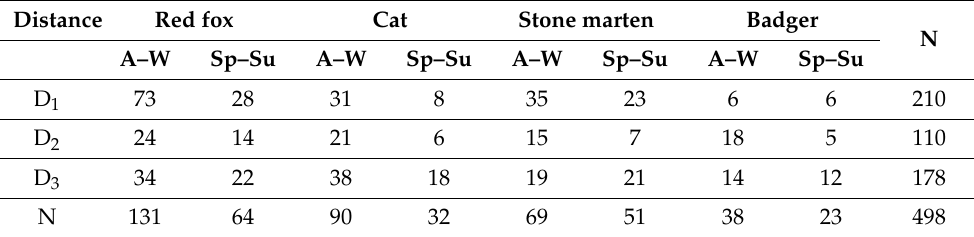
Table 1. Number of scats analyzed (N) to determine carnivore diet per species, season (A–W: Autumn–Winter; Sp–Su: Spring–Summer) and distance from road (D): D 1 : 0–50 m; D 2 : 500–550 m; D 3 : 1000–1050